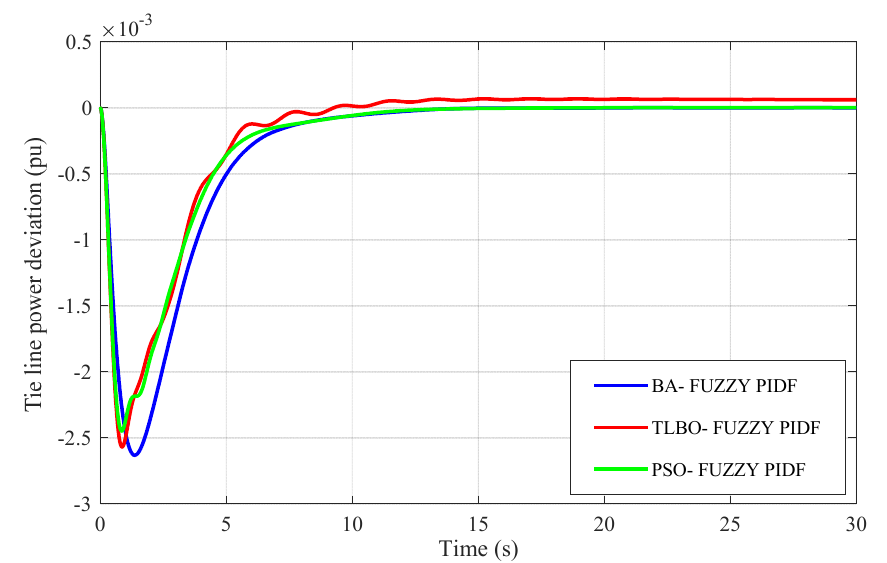
Figure 22. Frequency deviation in area 1 ( ∆ F 2 ) under parametric uncertainties.